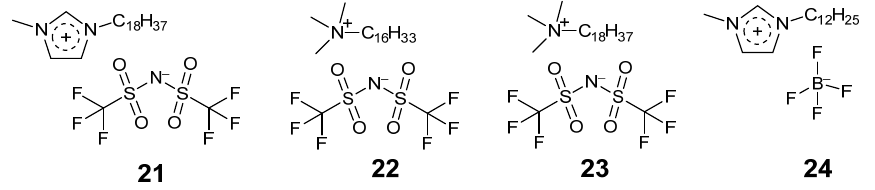
Figure 8. Chemical structure of sponge-like ionic liquids ( 21 – 24 ).